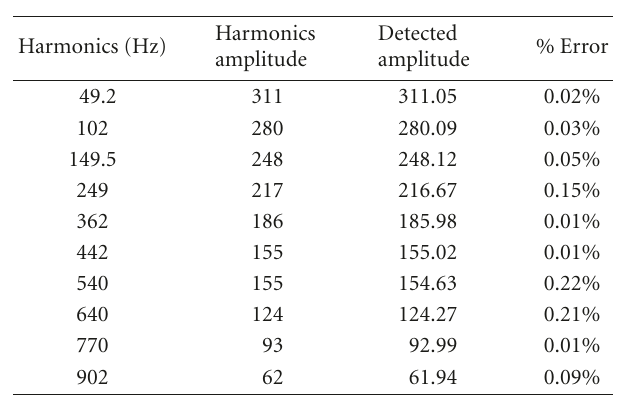
Table 4: Amplitudes detection results.